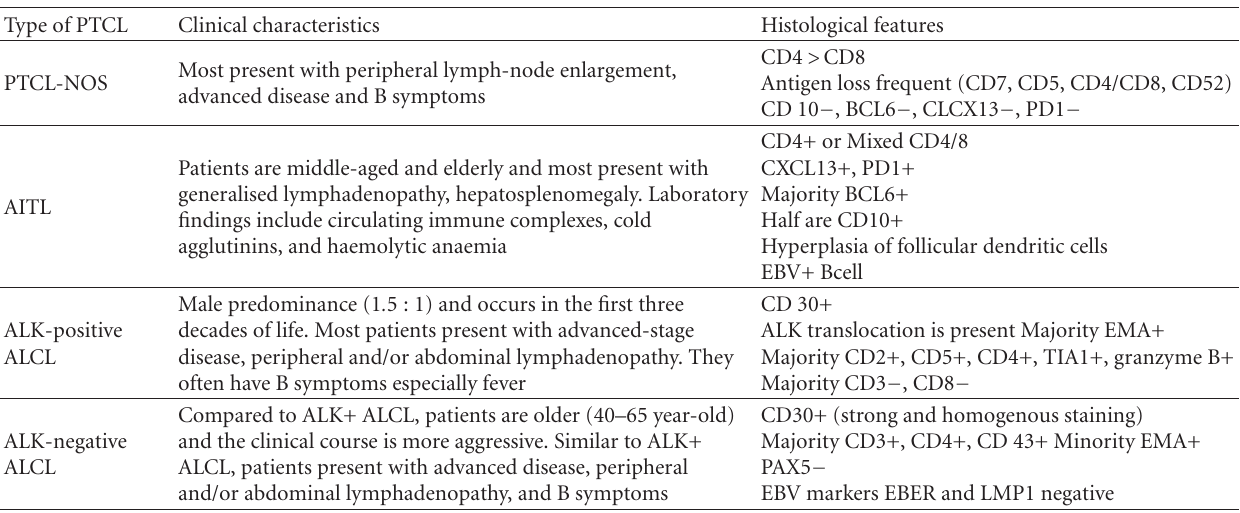
Table 2: Clinical and histological characteristics of the major PTCL